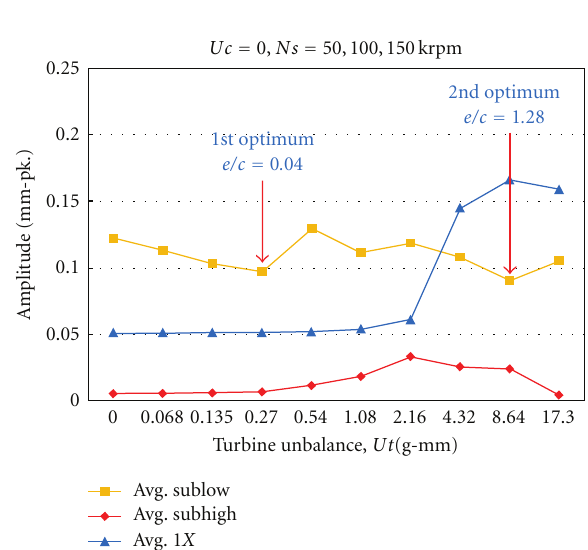
Figure 11: Predicted average compressor end (Station 1) vibration for induced compressor unbalance at speeds 50, 100, and 150